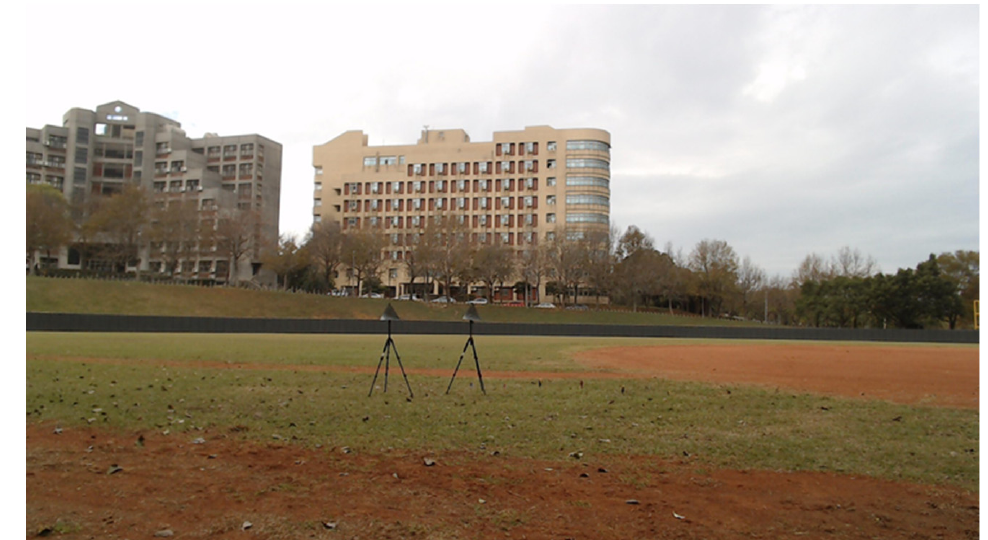
Figure 5. Experiments with two metal corner reflectors (targets).